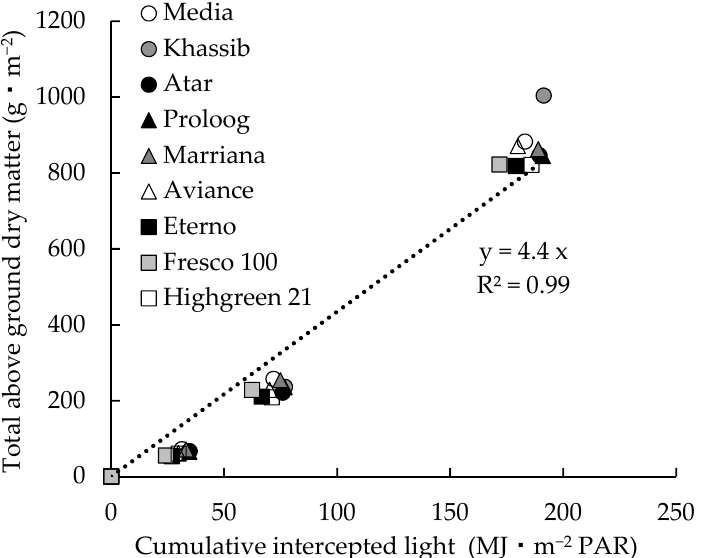
Figure 5. Total above-ground dry matter as a function of cumulative intercepted PAR in the nine cucumber cultivars. The slopes of the regression lines are light use efficiency.